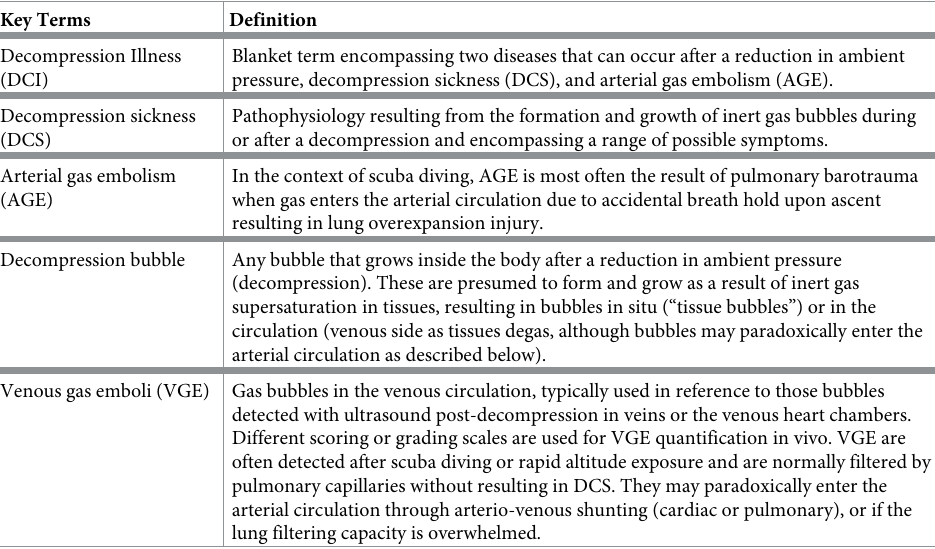
Table 1. Key terms and their definitions in the context of decompression